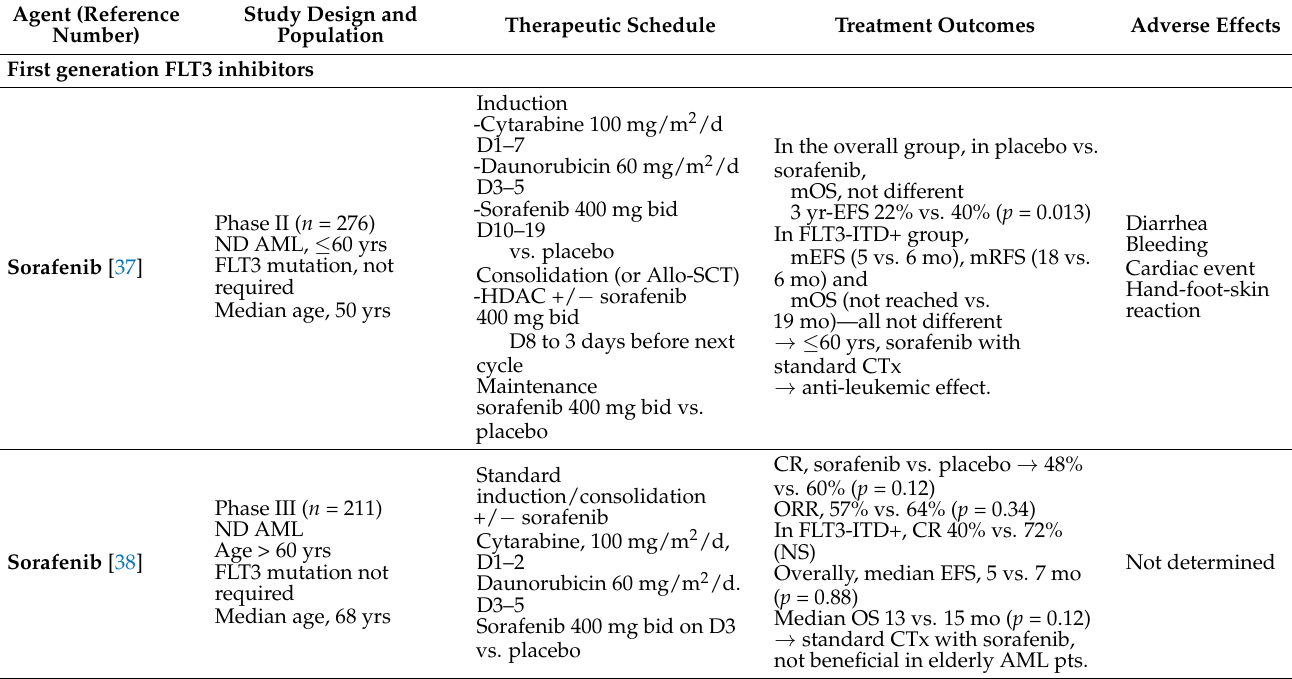
Table 1. Clinical trials of FLT3 inhibitors as front-line therapy in AML